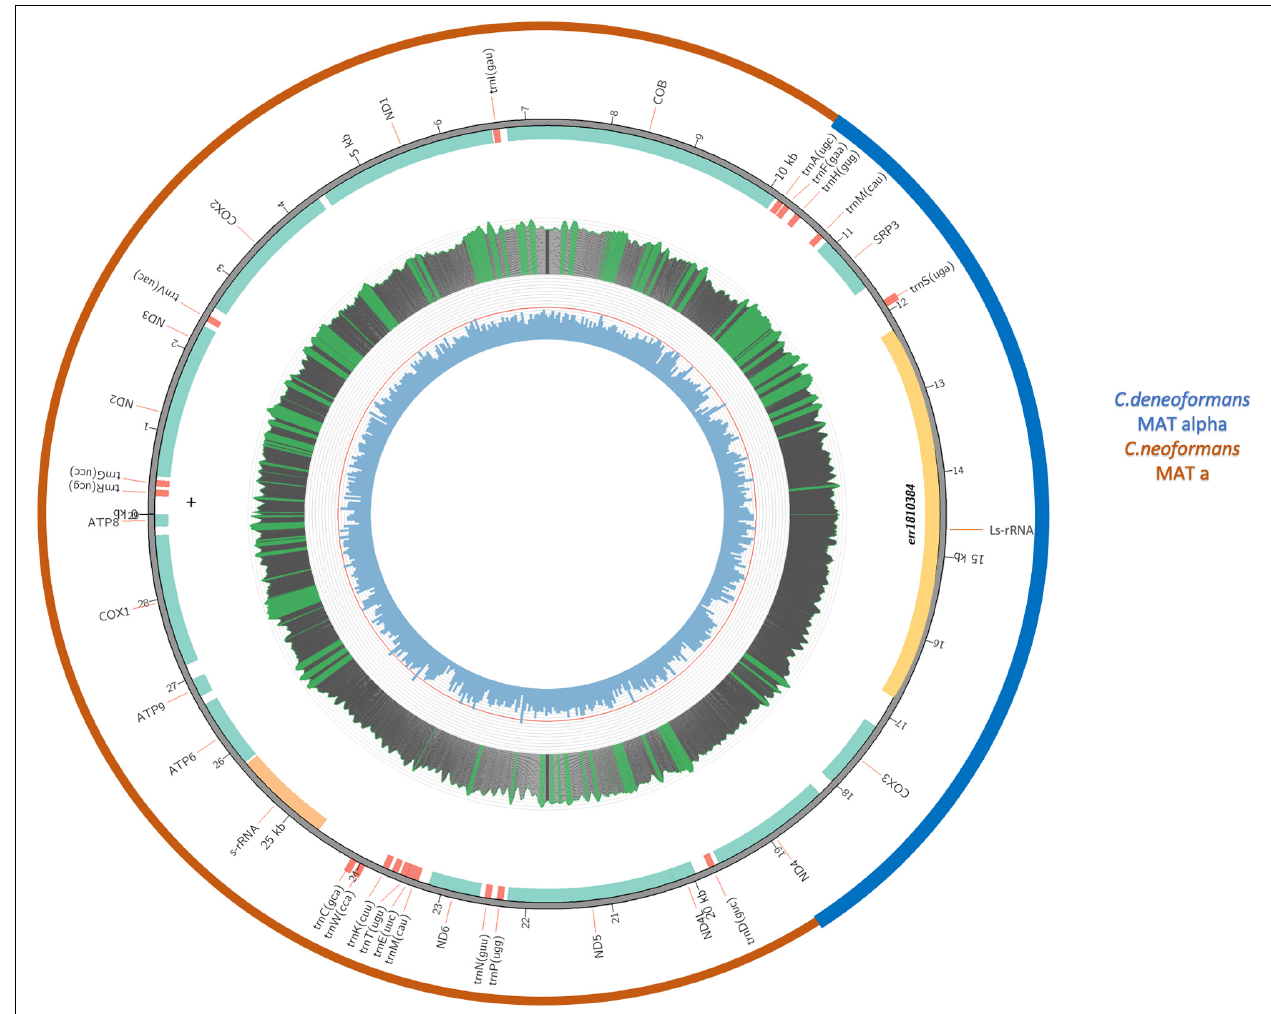
FIGURE 5 | A schematic diagram showing the composition of the eight VNB/VNIV hybrid mitogenomes. The inner circle indicates GC content, with the red line indicating 50% GC content. Middle circle indicates nucleotide coverage in sequence reads. For this sample, the coverage ranges from 5000 to 8000x. Green means the coverage is over top quartile; red means lower than 20x. The second circle from the outside indicates the locations of individual genes. The outermost circle indicates the likely origins of the mitogenome from either C. neoformans (Red) or C. deneoformans